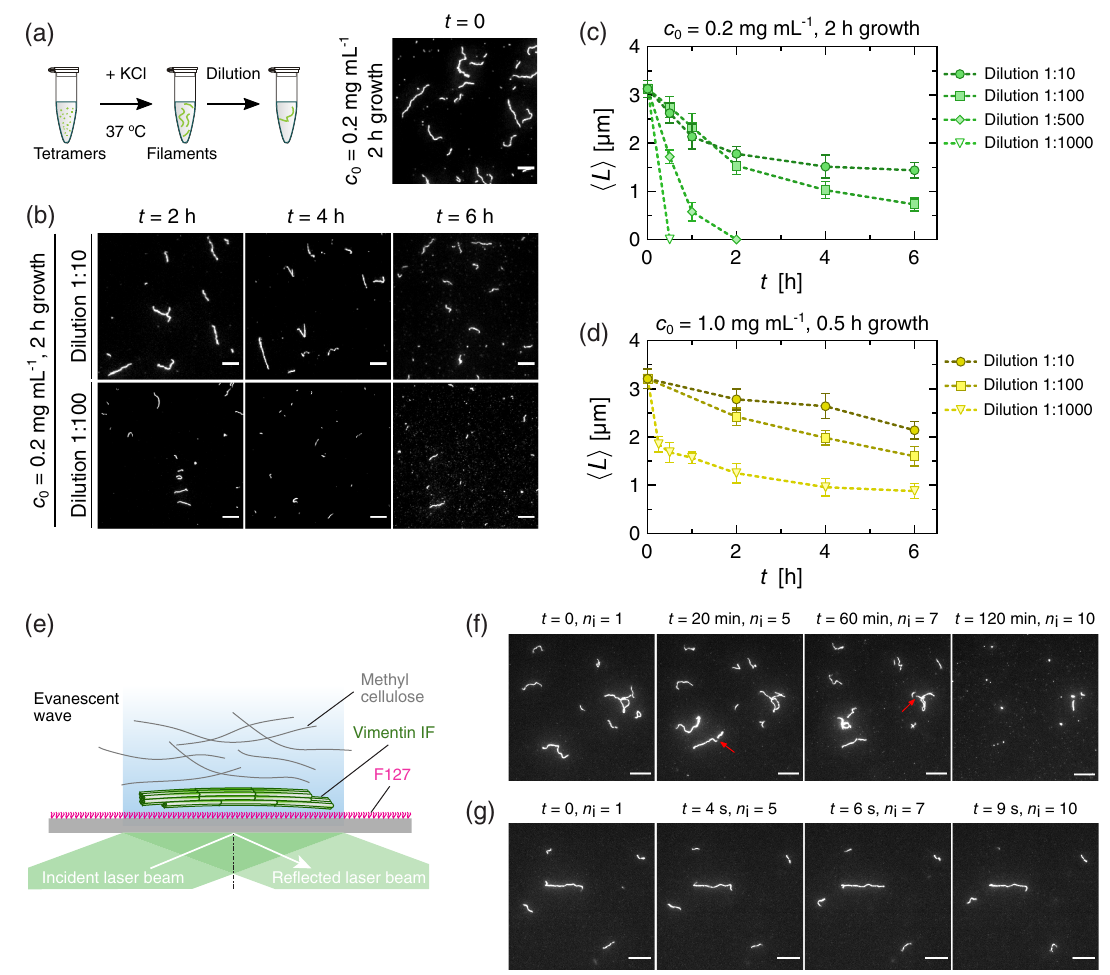
FIG. 4. Vimentin assembly is reversible. (a) Schematics of the dilution experiment. Vimentin filaments were preassembled in the assembly buffer at 37 °C. The obtained filaments were then diluted at different ratios from 1 ∶ 10 to 1 ∶ 1000 , and further incubated at 37 °C for up to 6 h. (b) Fluorescence images of vimentin filaments, with initial concentration 0 . 2 mg mL − 1 and assembled for 2 h, at different time points after dilution. Scale bar: 5 μ m. (c) Evolution of mean length of diluted filaments with initial concentration 0 . 2 mg mL − 1 preassembled for 2 h and (d) 1 . 0 mg mL − 1 for 0.5 h. Error bars are standard deviations over 3 repeats. Sample size: ∼ 200 filaments per condition and repeat. (e) Schematics of the experimental setup comprising the flow chamber observed using TIRF microscopy. The glass coverslip is passivated by F127 preventing the nonspecific adhesion of the filaments. Filaments are pushed close to the surface by the 0.2% methylcellulose present in solution; they float without adhering to the surface. (f) Fluorescence images of diluted filaments in the flow chamber at different time points after dilution. Vimentin filaments were preassembled in the assembly buffer at 37 °C with initial concentration of c 0 ¼ 0 . 2 mg mL − 1 and 10% labeling rate, then diluted at a ratio of 1 ∶ 1000 in the assembly buffer with addition of 0.2% methylcellulose and observed at ∼ 35 °C. Red arrows indicate the fragmentation events. n illumination times. (g) Phototoxicity control for the diluted filaments in the flow chamber. The filaments were imaged with a time interval of 1 s. We did not observe any filament breaking events after 10 illuminations. Scale bar: 10 μ